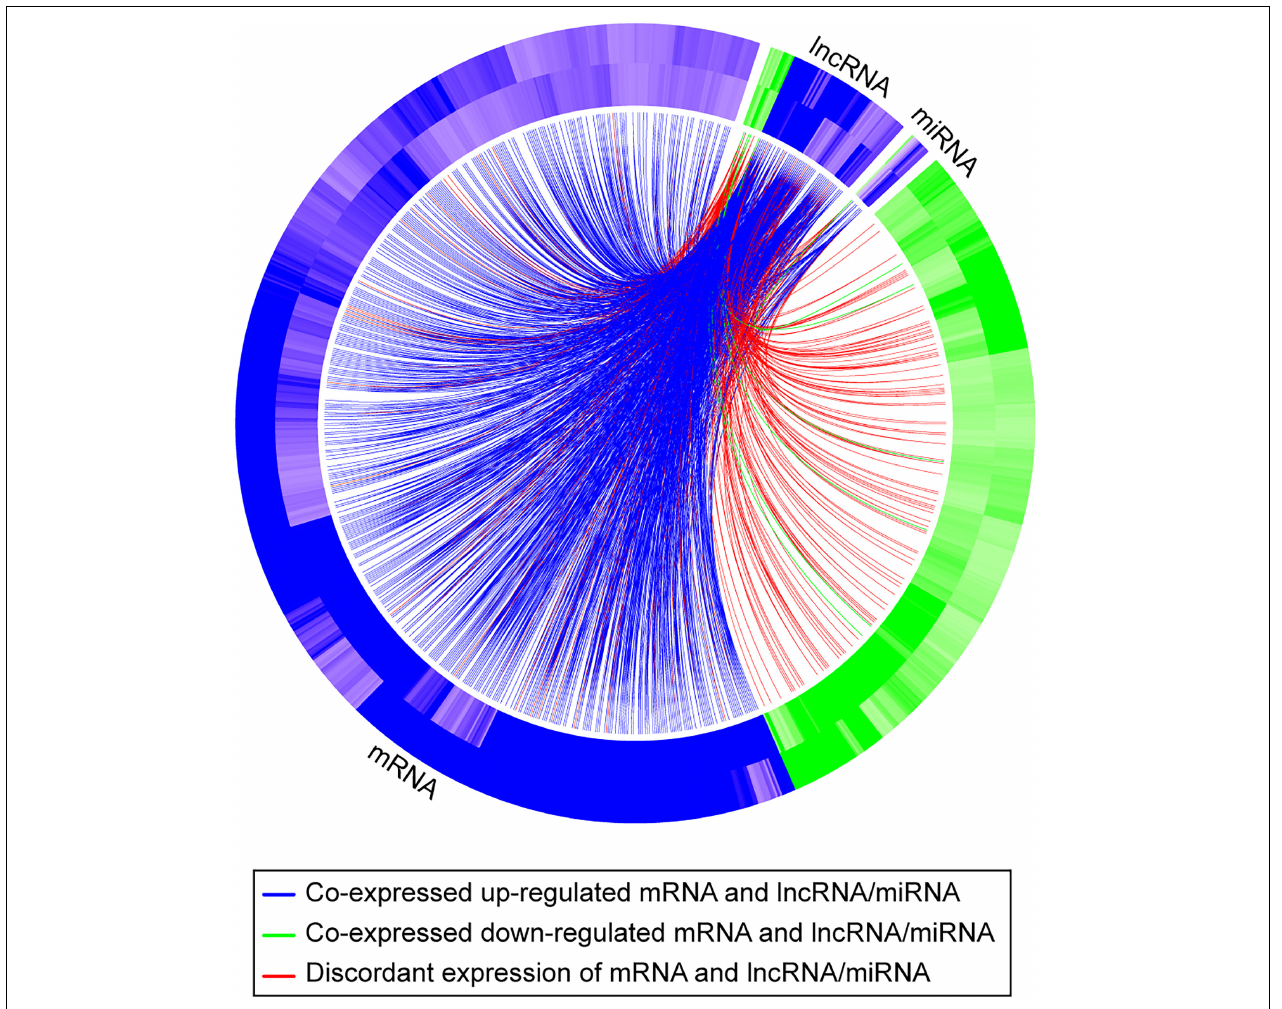
FIGURE 6 | A Circos plot depicting the association of mRNAs, lncRNAs, and miRNAs that exhibit a concordant expression change in the two exposures (hypoxia and DMSO). The outer band of the ring represents log2 fold changes in standard vs. hypoxia exposure, and the inner band of represents log2 fold changes in standard vs. DMSO exposure. Blue denotes that the RNA is upregulated; green denotes that the RNA is downregulated. The curved lines connect each lncRNA/miRNA to the co-expressed mRNAs, with blue (upregulation) and green (downregulation) lines representing positive correlations and red lines representing negative